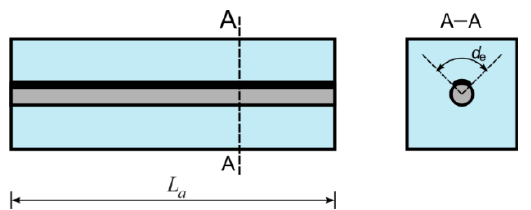
Figure 4. RC beam with circumferential debonding along the whole specimen length.